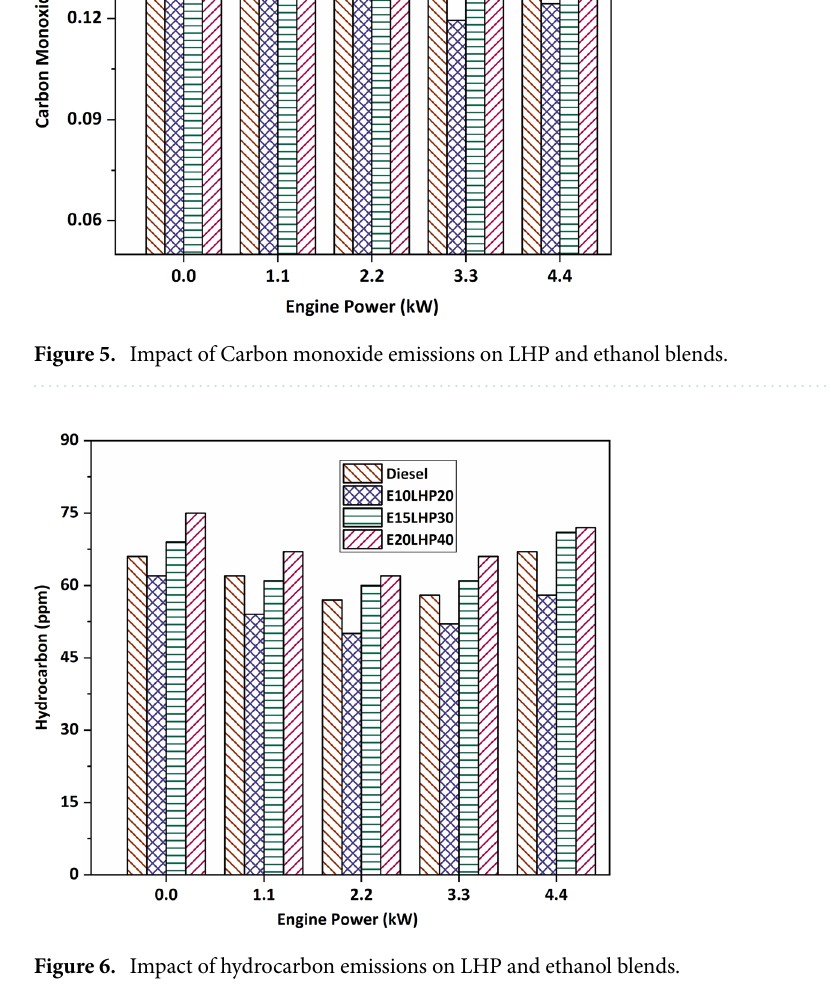
Figure 6. Impact of hydrocarbon emissions on LHP and ethanol